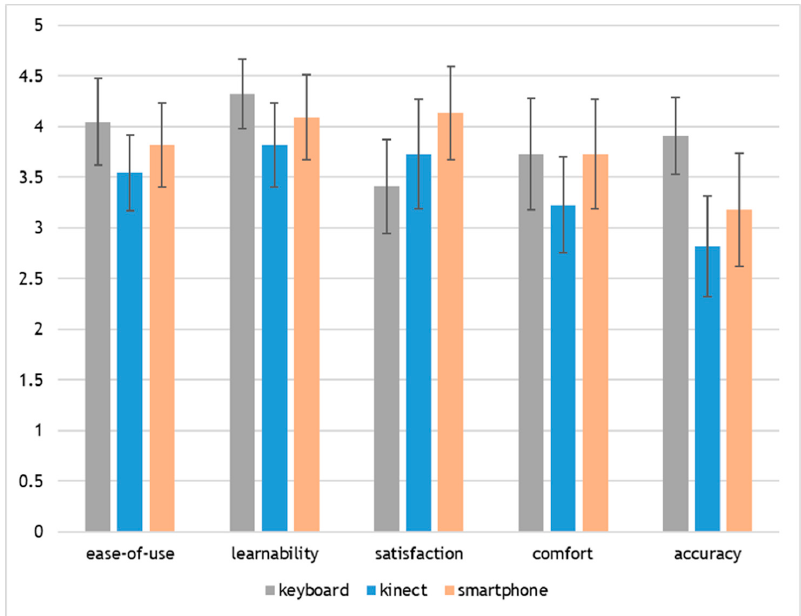
Figure 5. Mean values of subjective user ratings regarding ease-of-use, learnability, satisfaction, comfort, and accuracy. Error bars represent 95% confidence intervals.